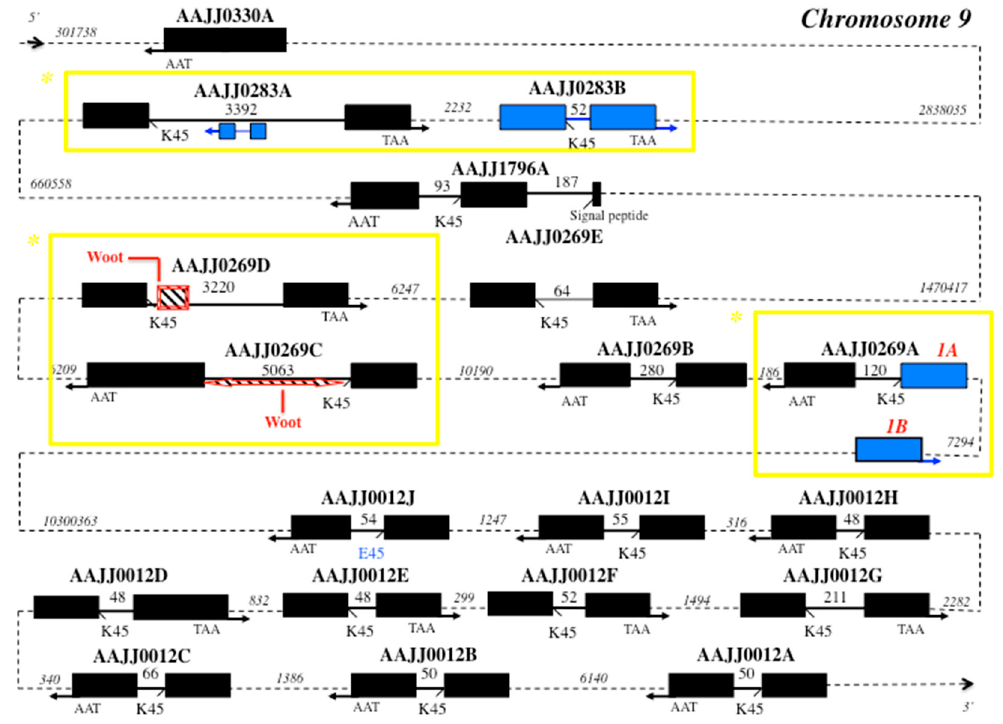
Figure 2. Genomic organization of CSP genes in T. castaneum (chromosome 9). Genes are described in Table S1. Black boxes: exons, bold plain lines: introns, dotted lines: intergenic intron regions ( length in bps). K45 indicates intron position at the level of lysine residue at position 45. E45 (in blue) indicates lysine-to-glutamic acid switch in the exon/intron boundary at position 45 in AAJJ0012J. The arrow indicates the 5 ′ –3 ′ (right) or 3 ′ –5 ′ (left) orientation of the gene. In blue shows particular genetic markers for Tribolium CSPs: inverted duplicated gene in AAJJ0283A , duplicated exon in AAJJ0269A , and Woot retroposon in AAJJ0269C and AAJJ0269D . The position of Woot retroposon is indicated by a bevel box with the diagonals (downward), showing the orientation of the retroposon in AAJJ0269C and AAJJ0269D : 5 ′ –3 ′ . The yellow squares pinpoint potential strain-specific regions for biotyping in Coleoptera (*).